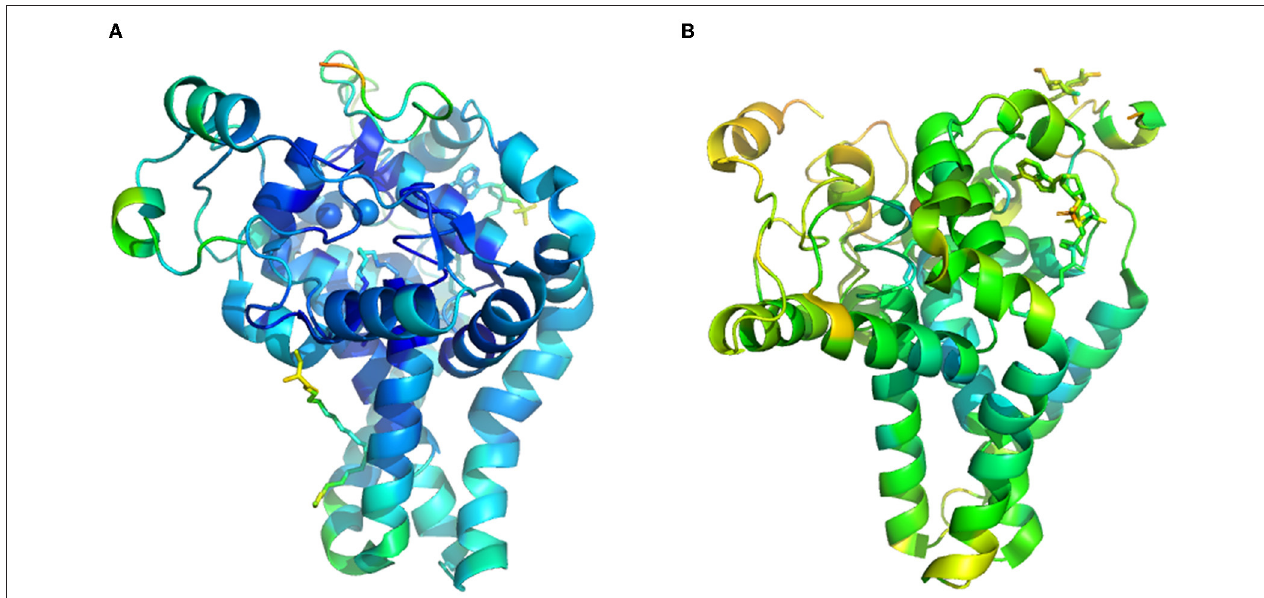
FIGURE 2 | The crystal structure of transmembrane fatty acid desaturases. (A) , crystal structure of mouse stearoyl-CoA desaturase (PDB ID: 4YMK). (B) , human integral membrane stearoyl-CoA desaturase (PDB ID: